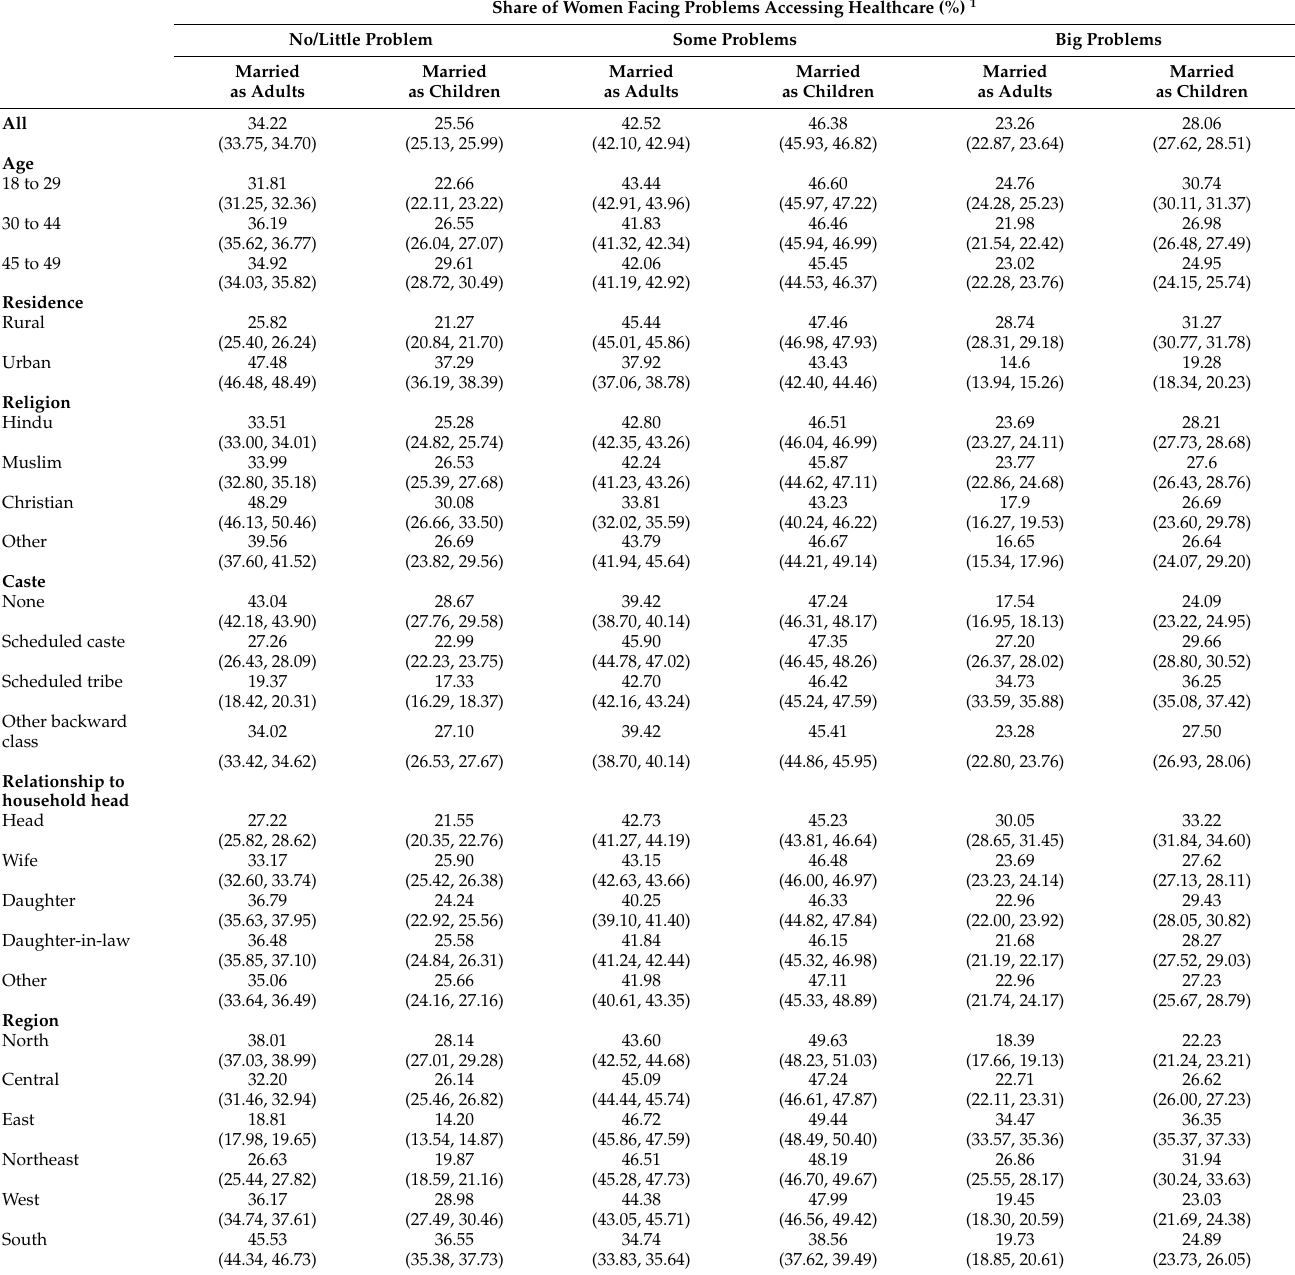
Table 4. Share of women facing problems accessing healthcare according to degree of problems, marriage age, and sociodemographic